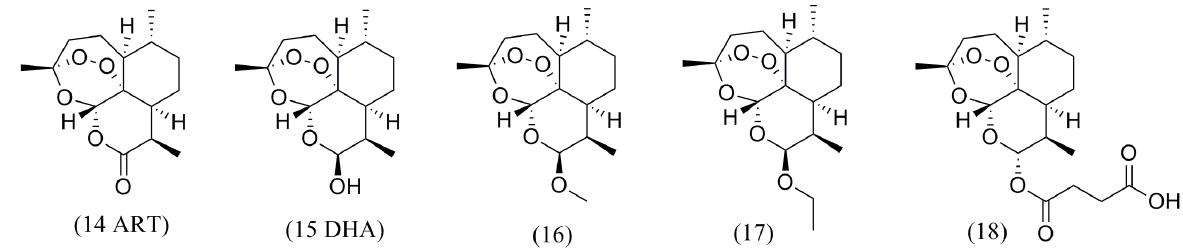
Figure 4 - Artemisinin derivatives used in the treatment of